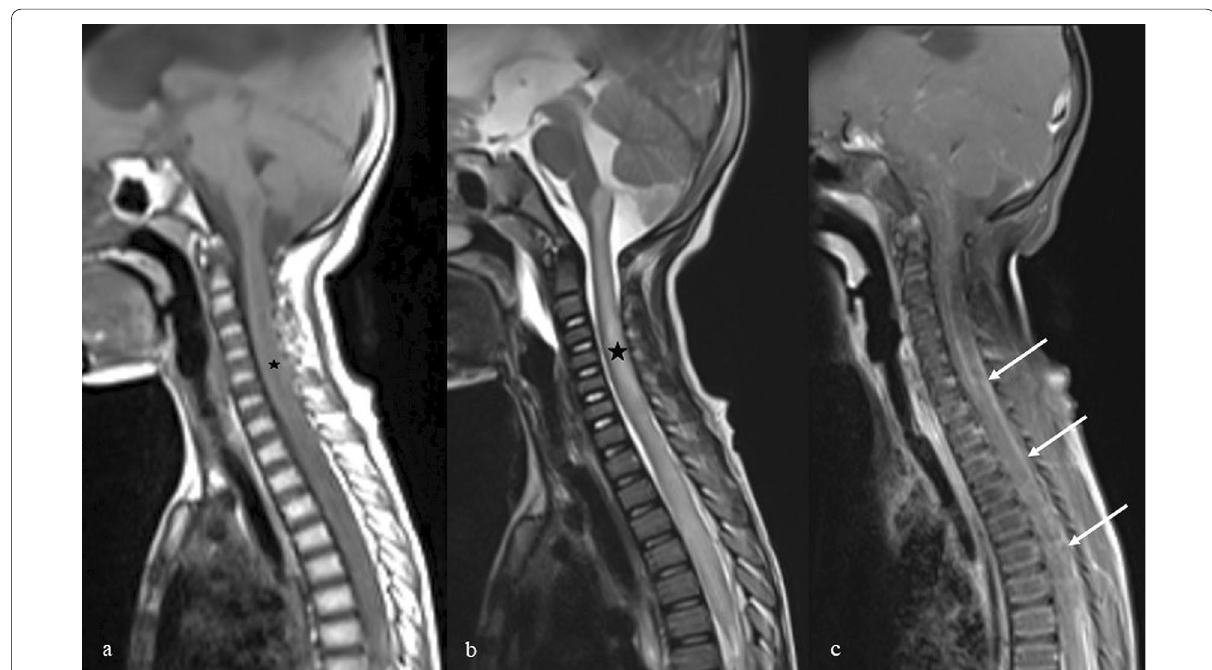
Fig. 2 Sagittal T1 ( a ), T2 ( b ), and T1 post-contrast ( c ) images show long segment T1 hypointense and T2 hyperintense signal abnormality in cervicothoracic cord extending from cervicomedullary junction inferiorly (asterisk). There is a corresponding patchy postcontrast enhancement